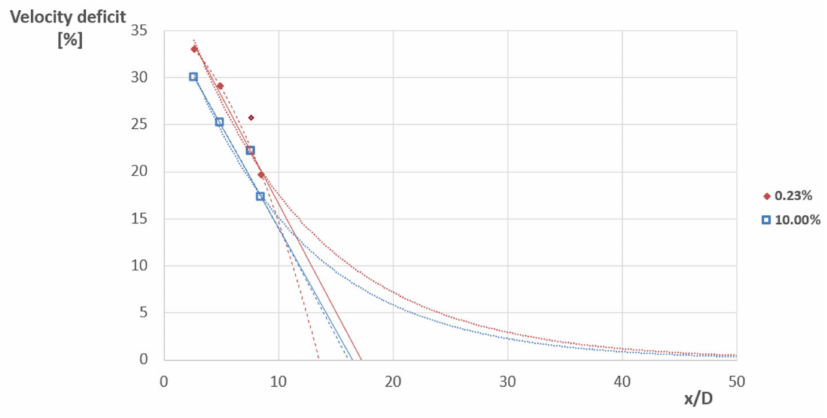
Figure 9. Velocity deficit downstream wind turbines (vertical profile data): data points and their proposed modeling